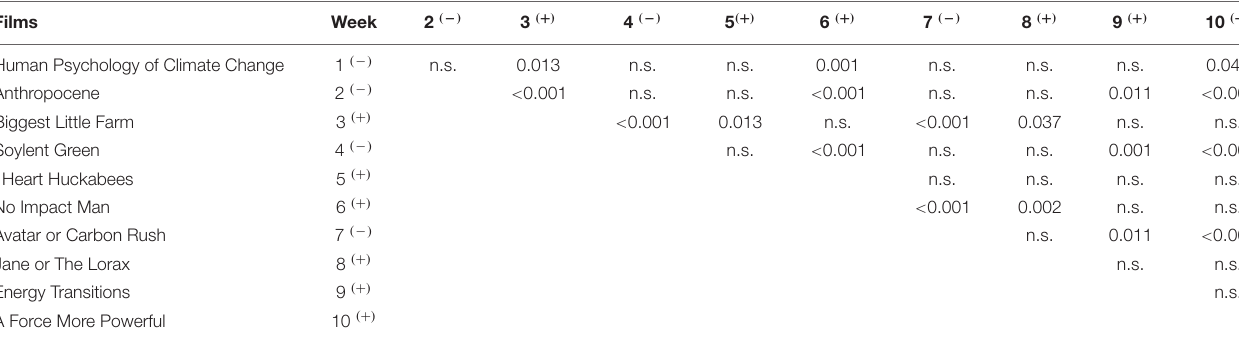
FIGURE 2 | Stem-and-leaf plots of sentiment analysis for weekly reflections using R-software and the Bing Liu Lexicon (Hu and Liu, 2004). TABLE 4 | Analysis of variance Tukey HSD statistics summary comparing sentiments in reflection texts between the 10 thematic